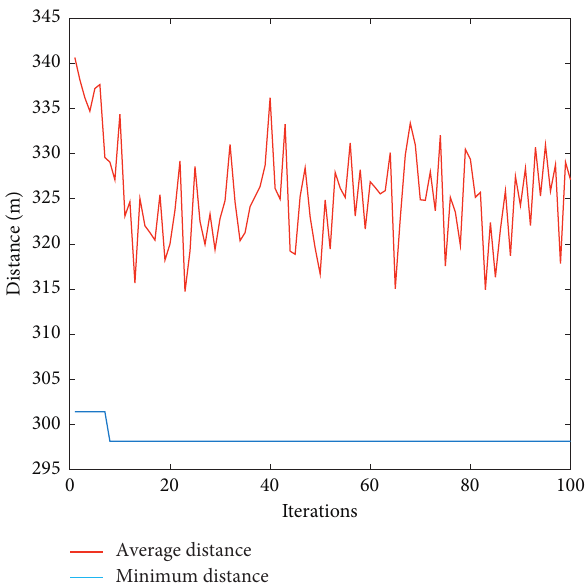
Figure 11: Predicted path length at the beginning of the second